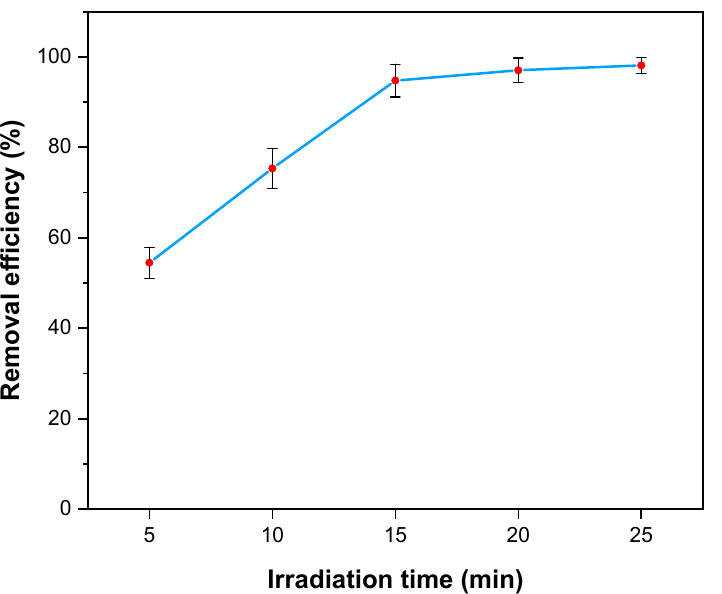
Figure 12. Effect of time on the photocatalytic removal of MB with B–ZnO/TiO 2 (initial MB concentration: 15 mg/L; photocatalyst amount: 30 mg; pH: 11; irradiation time: 5–25 min).